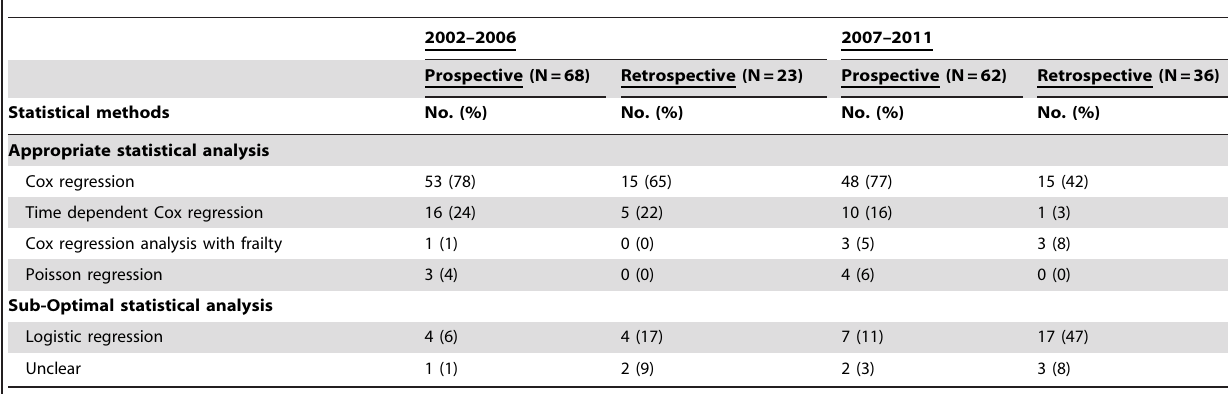
Table 4. Appropriateness of statistical methods for predictors of